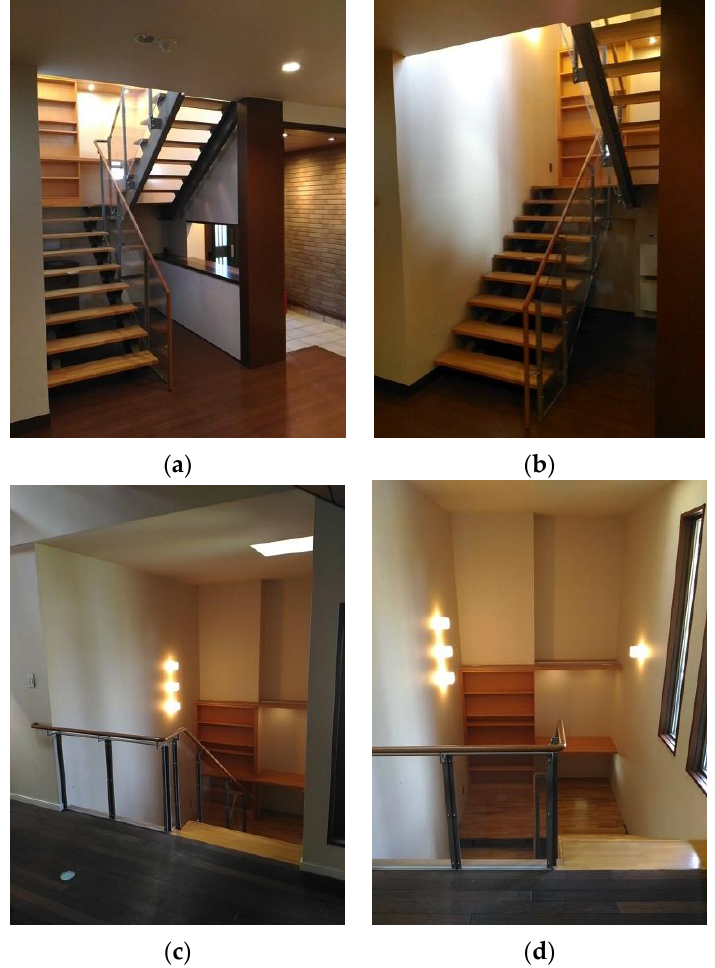
Figure 3. Stairwell used in the experiment. ( a ) As seen from the first floor, side 1; ( b ) As seen from the first floor, side 2; ( c ) As seen from the second floor, side 1; ( d ) As seen from the second floor, side 2.